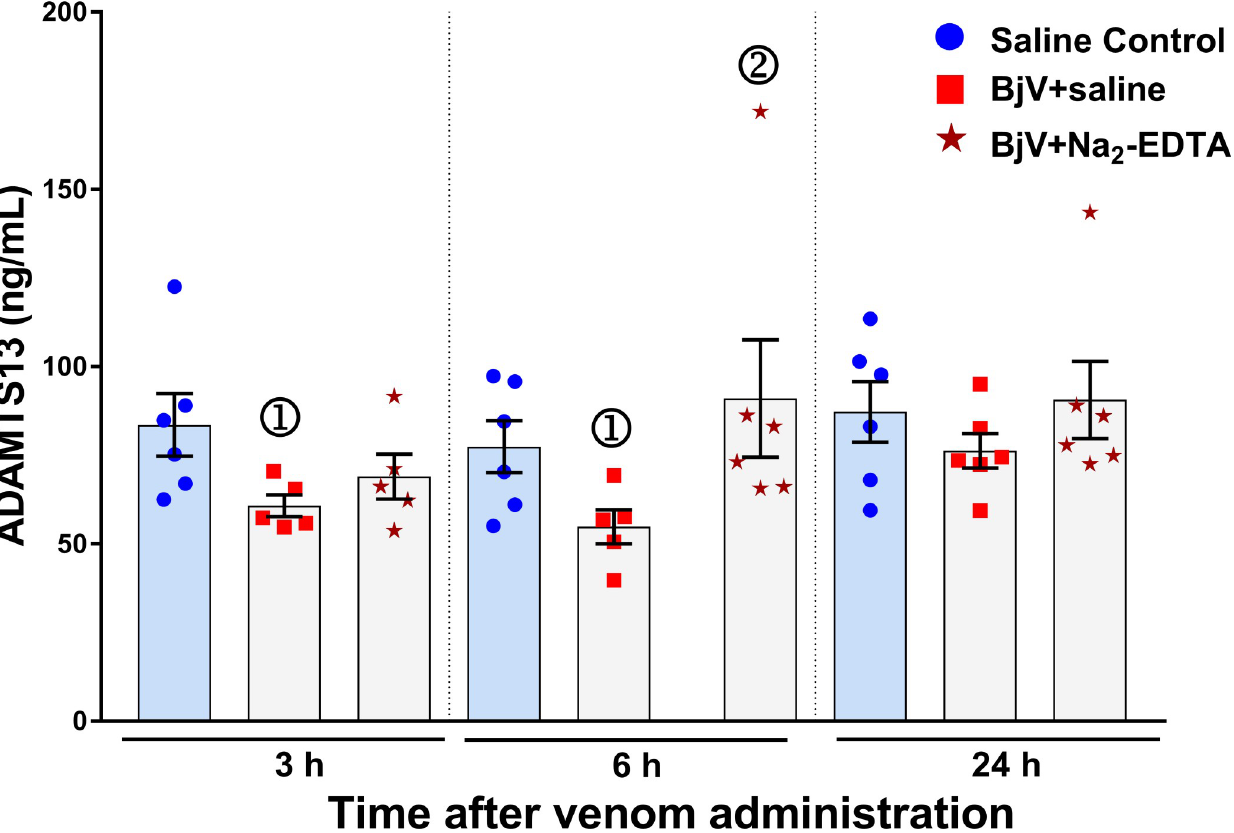
Fig 4. Plasma levels of ADAMTS13 in rats 3, 6 and 24 h after BjV administration. Rats were injected with saline alone (saline control, blue bars), or BjV previously incubated with saline (BjV+saline), and BjV+Na 2 -EDTA. ① —Group statistically different (p < 0.05) from the saline control group at the respective time. ② - Group statistically different (p < 0.05) from the BjV+saline group at the respective time. Data are expressed as mean ± s.e.m (n = 6–16 rats/group per time period).